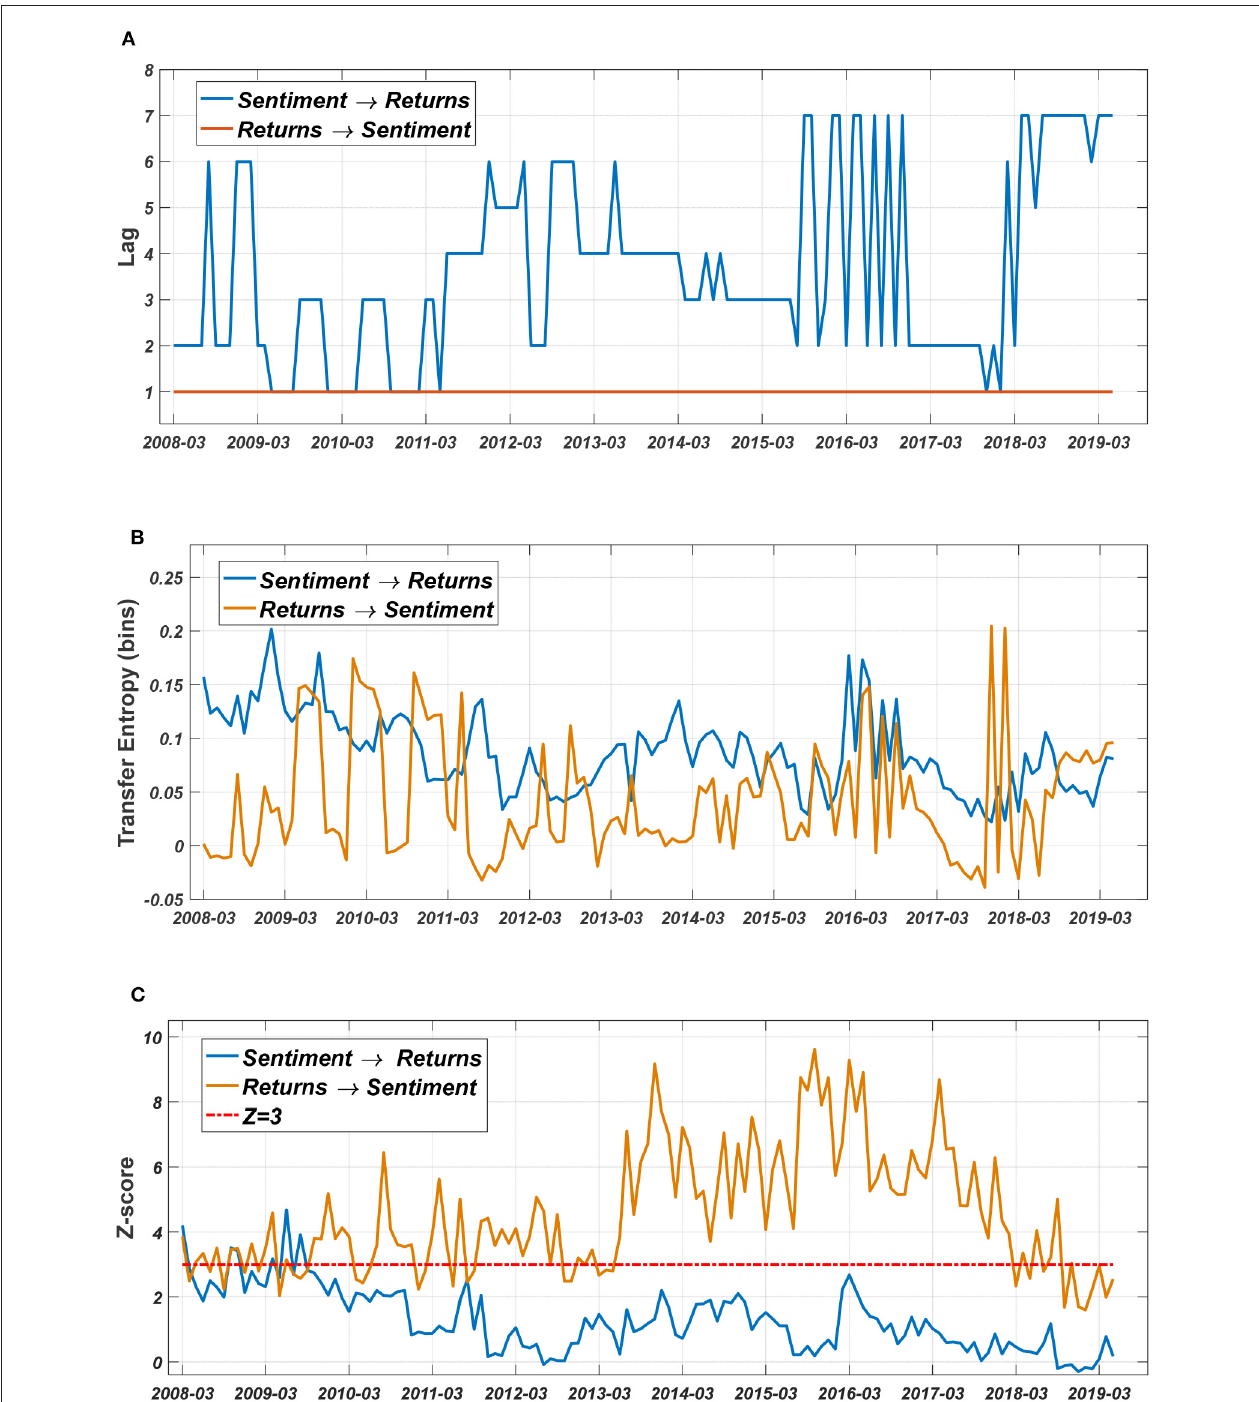
FIGURE 7 | Entropy between investor sentiment and stock market. (A) Lag structure. (B) TE fluctuation. (C) Z -score.